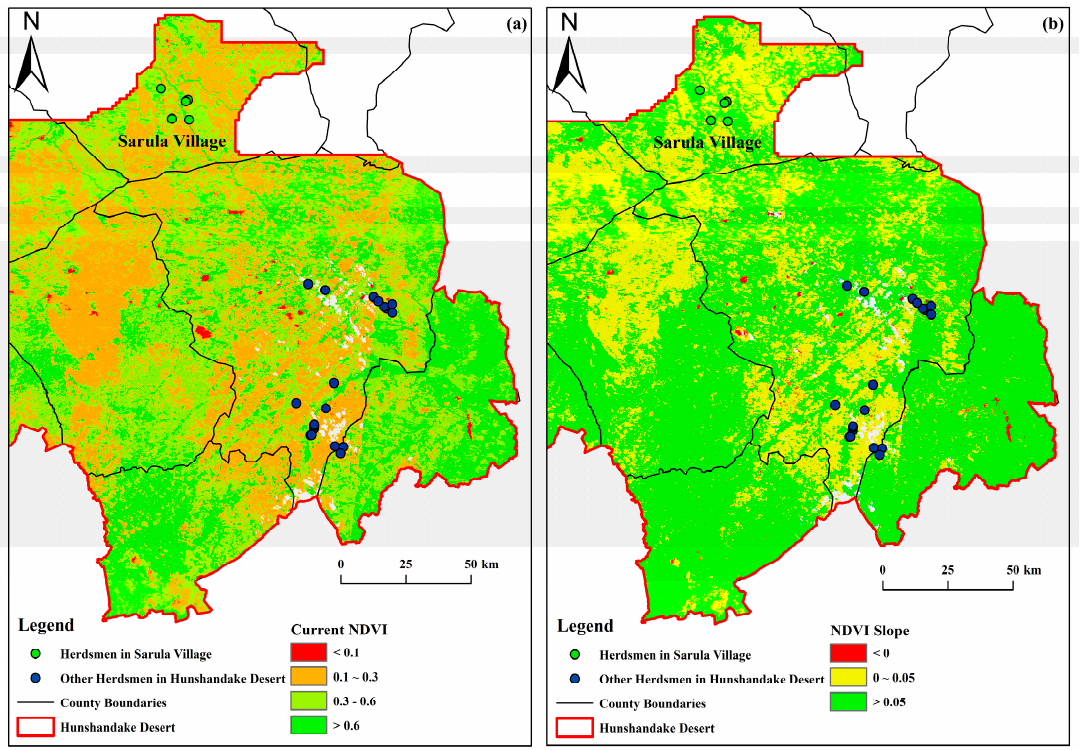
Figure 5. The spatial variations of (a) current NDVI, and (b) NDVI slope inside the rangelands of herdsmen in Sarula village and others in the Hunshandake desert.